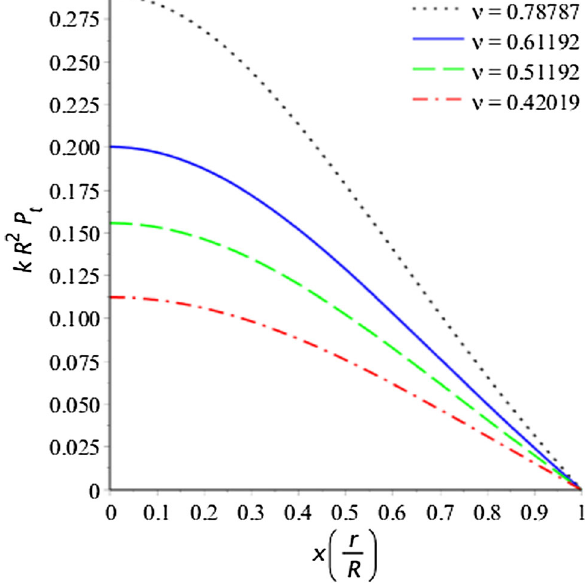
Fig. 2 Graphical representation of the quintessence matter’s density